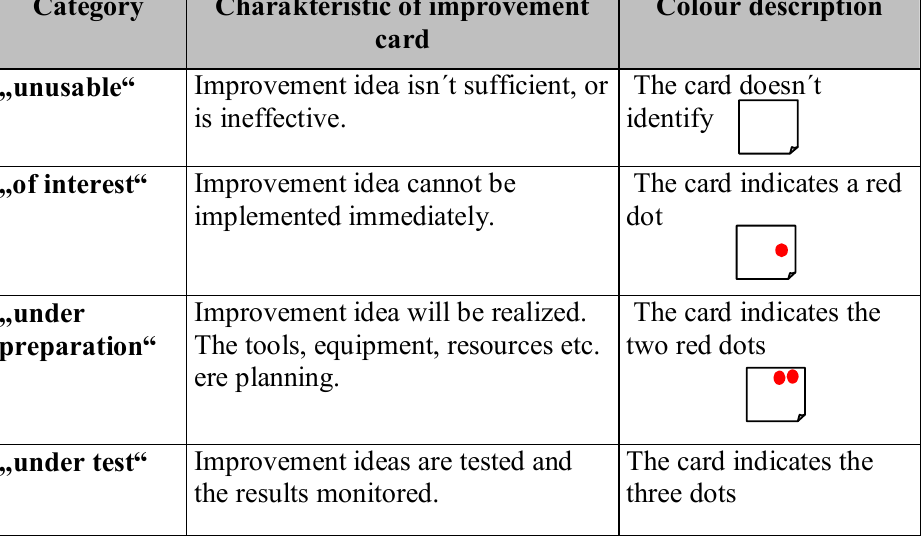
Table 5 - CEDAC Diagram Improvement cards categories